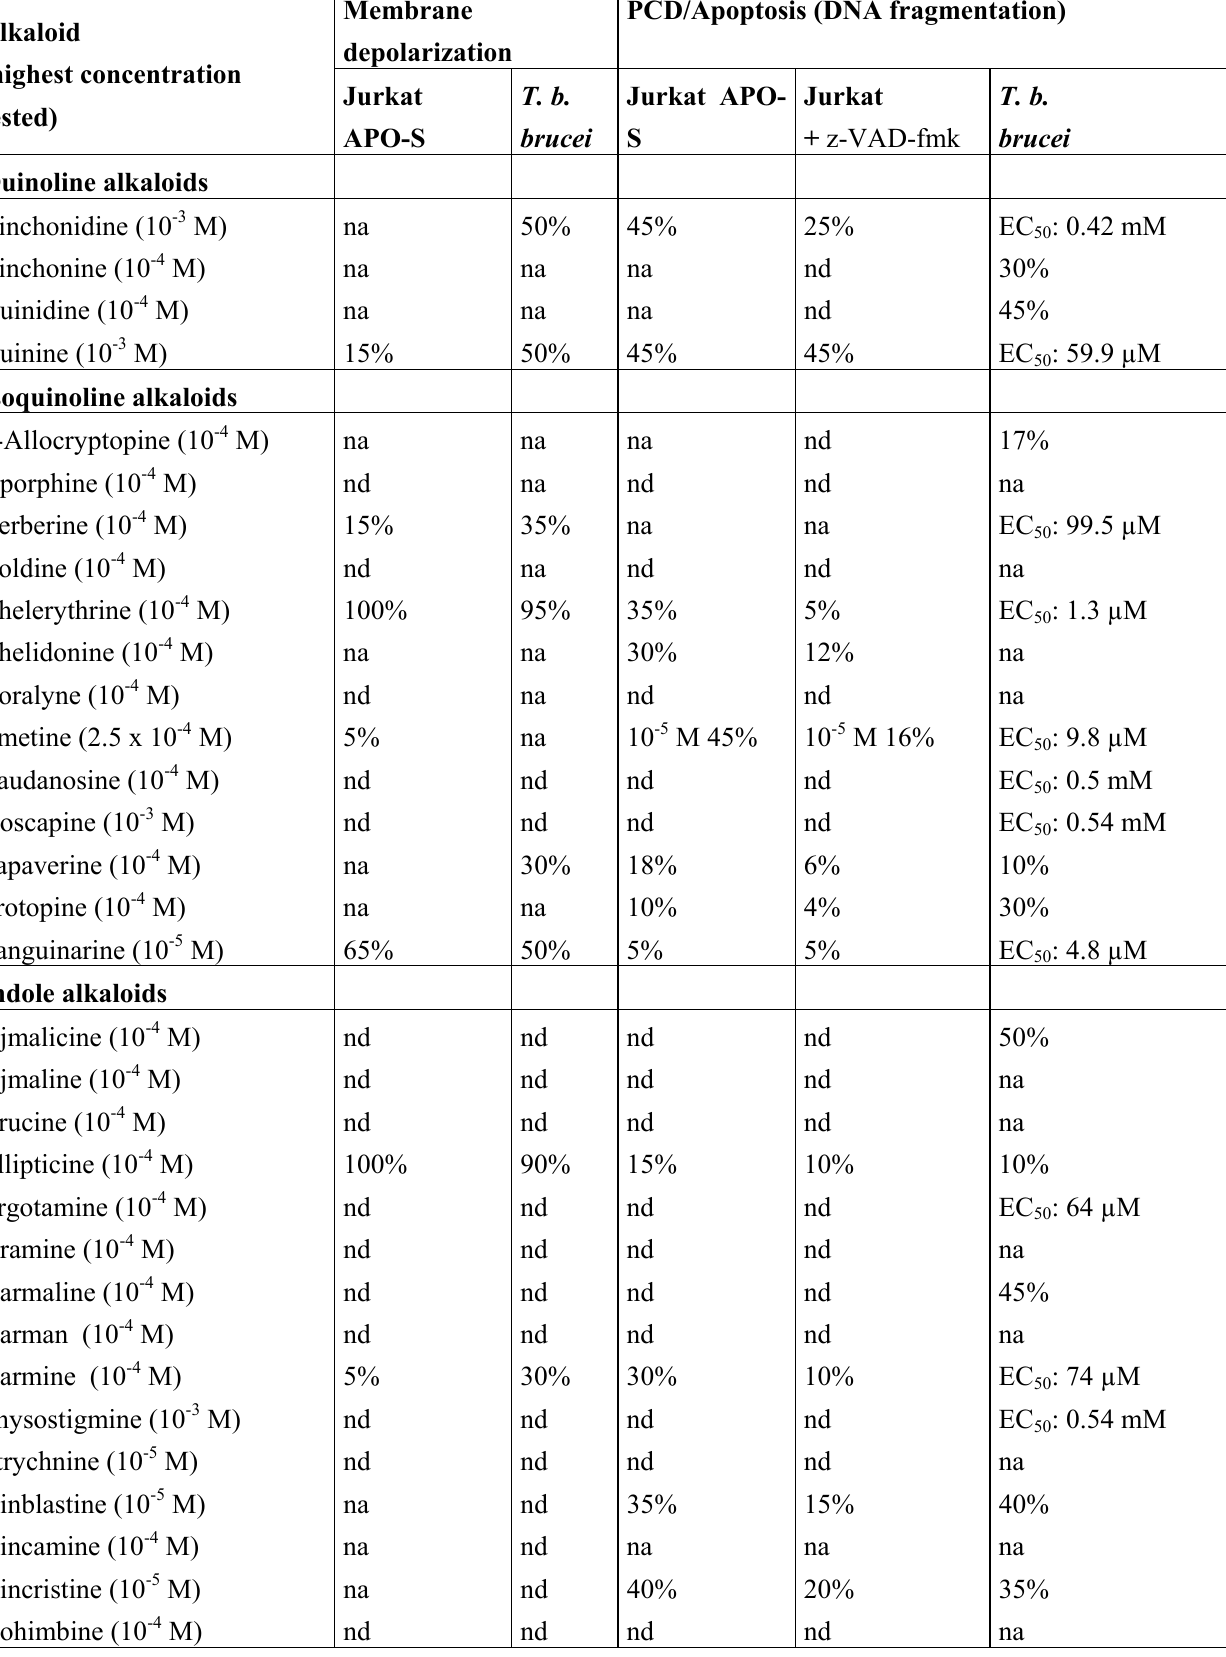
Table 1. Induction of apoptosis in Trypanosoma b. brucei and in Jurkat APO-S